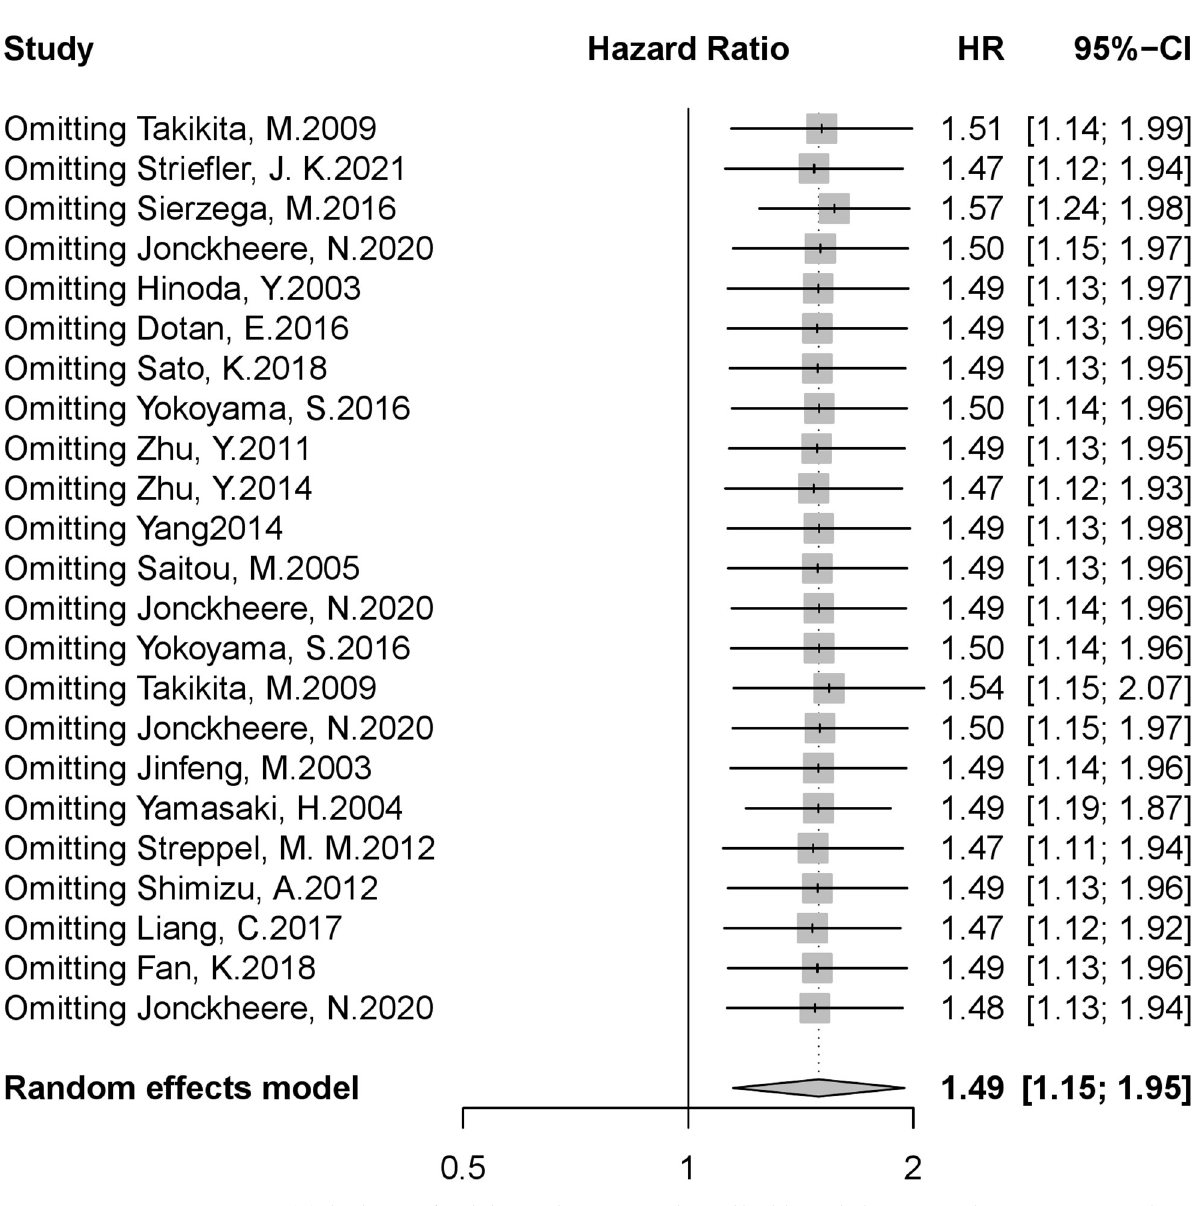
Fig 5. Result of sensitivity analysis. (A)The changes of pooled HR and 95%CI were observed by deleting the literature one by one. Sensitivity analysis showed the results was stable. (B) Pooled HR ranged from 1.47 to 1.57 and the 95% CI ranged from 1.11 to 2.07.